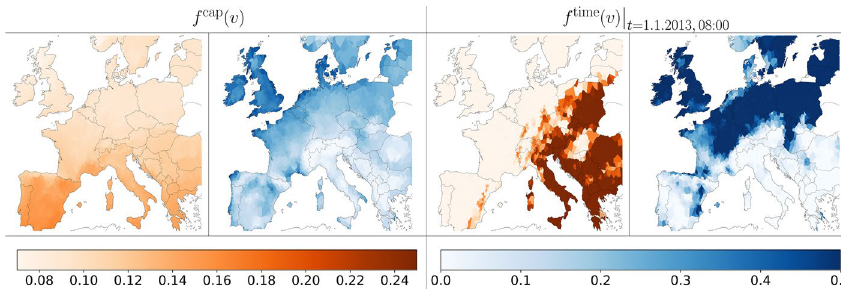
Fig. 2 Examples of the different features for solar (orange) and wind (blue). The left column displays the annual capacity factors, the right column a snapshot at 8 o’clock in the morning on the 1 st of January 2013. Both are displayed for the full resolution model of 2435 nodes, recognisable by the white boundaries of the voronoi